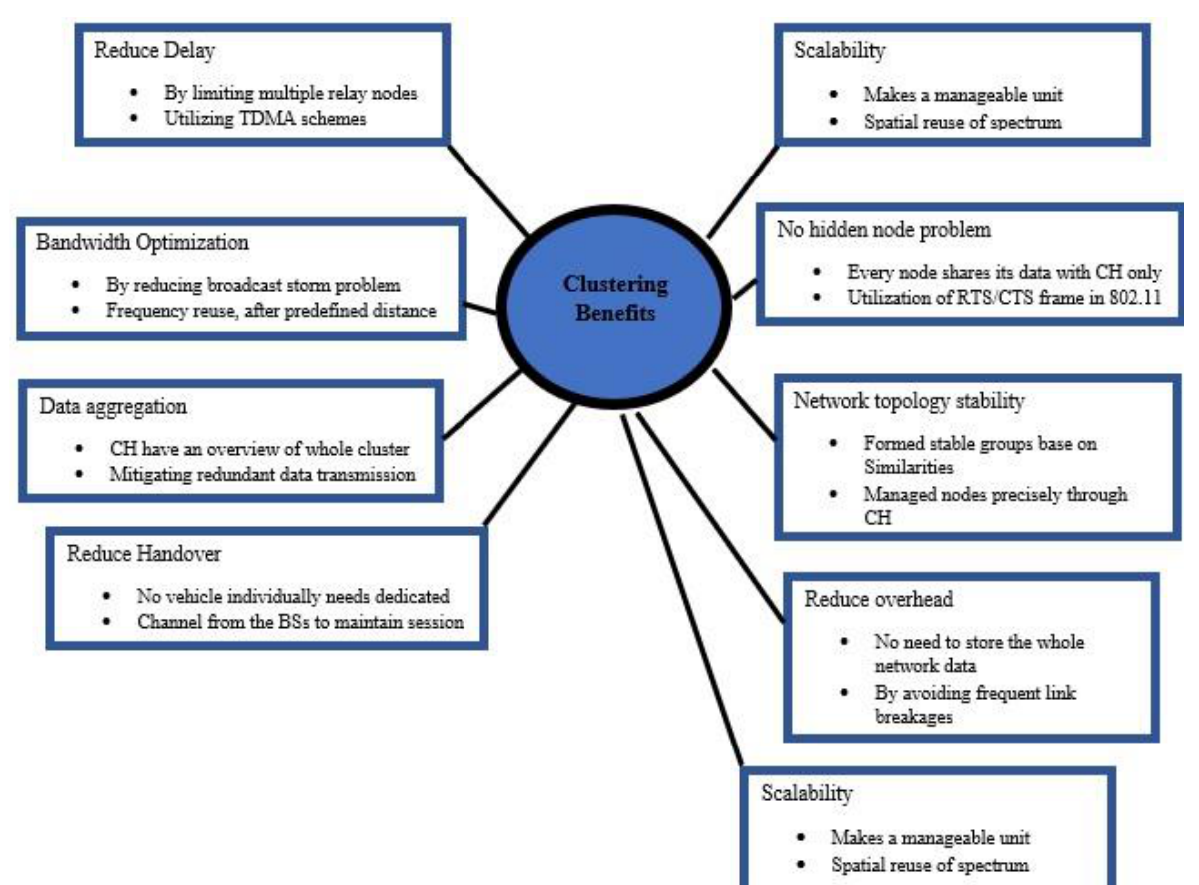
Figure 1. Cluster Optimization Advantages in VANETs [19].